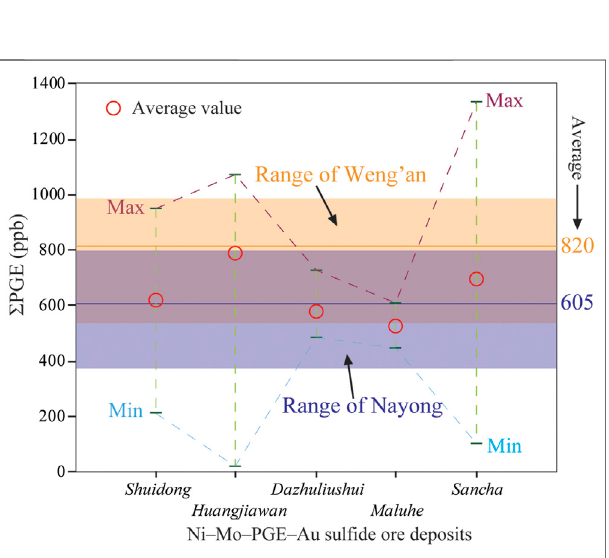
Frontiers in Earth Science |